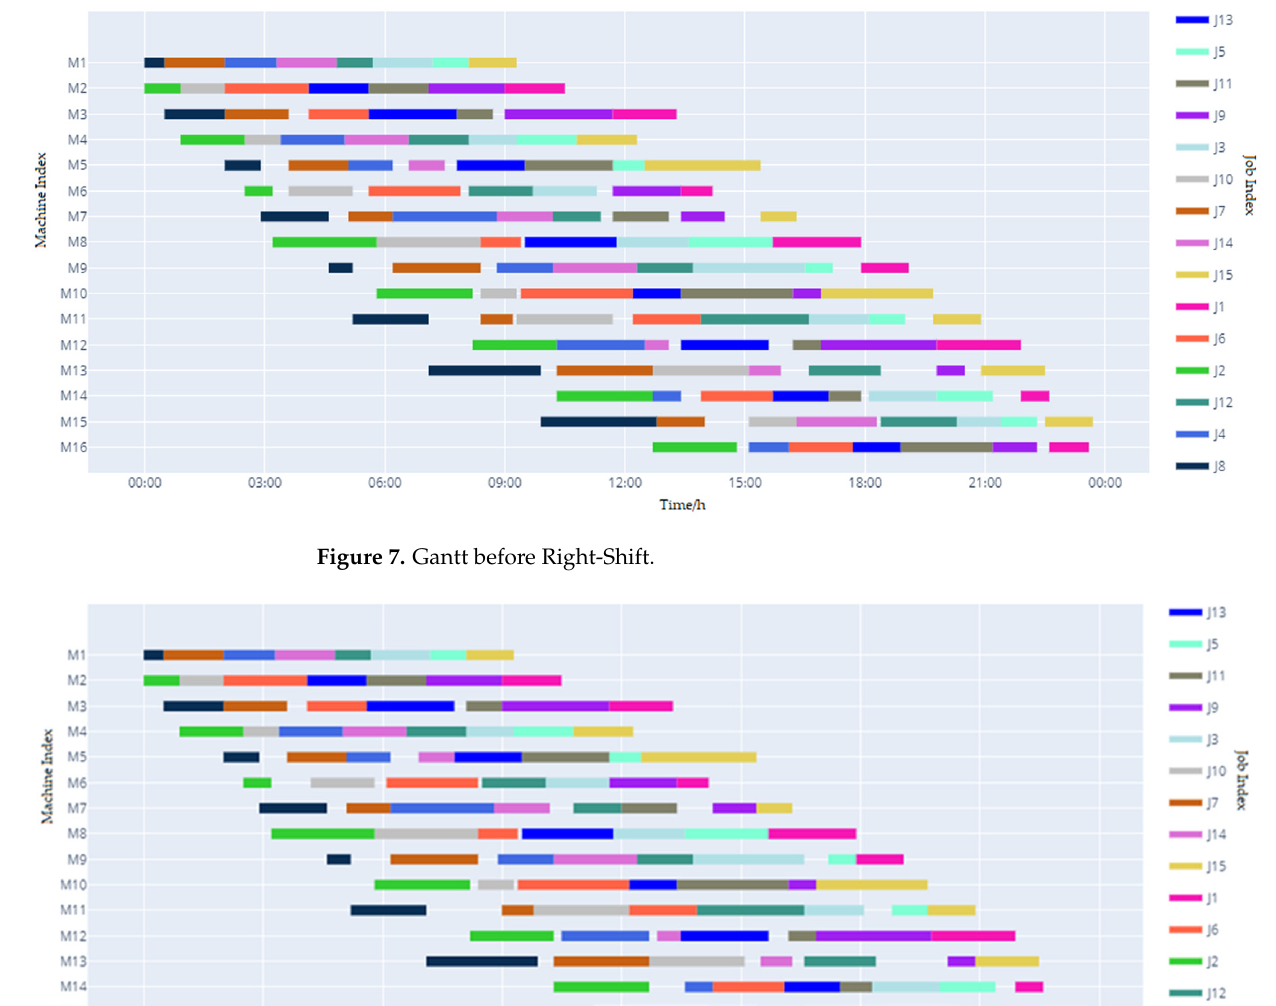
ladder electricity price (f1 = 23.6 h, f2 = 6453.08 yuan).